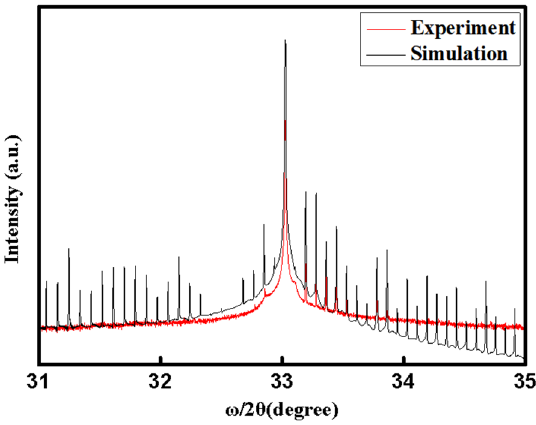
Figure 1. High resolution XRD spectrum and theoretical simulation curve of the wafer.